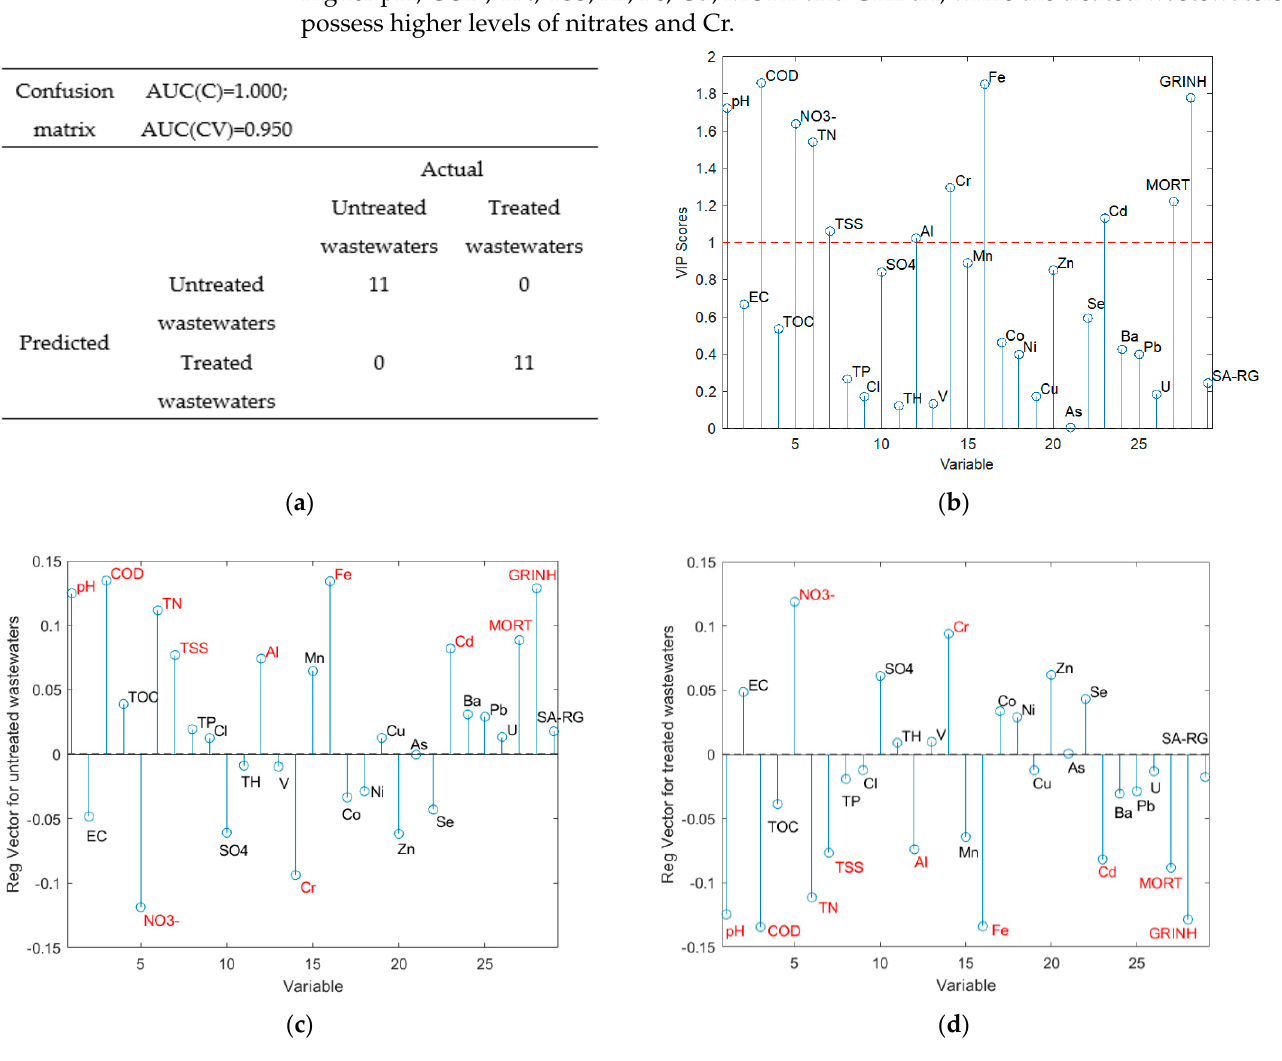
Figure 6. The partial least squares–discriminant analysis (PLS-DA) model results for untreated wastewaters and treated wastewaters based on physicochemical parameters and ecotoxicological endpoints: ( a ) Confusion matrix; ( b ) VIP (variable importance on projection) scores; ( c ) Regression vector for untreated wastewaters (variables with significant contribution are marked in red); ( d ) Regression vector for treated wastewaters (variables with significant contribution are marked in red).